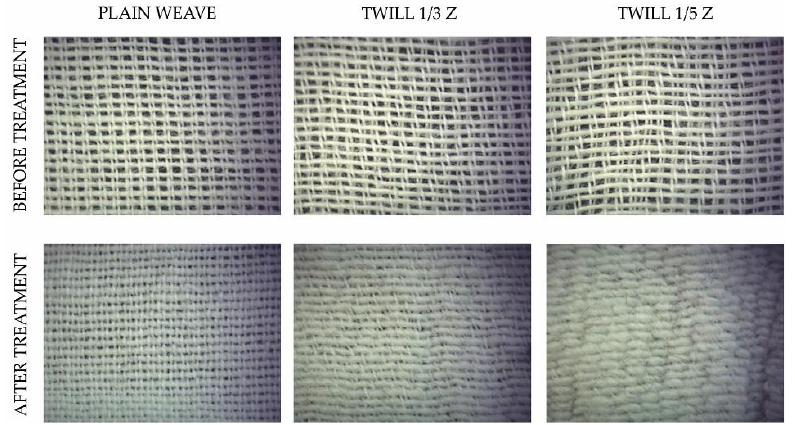
Figure 4. Pictures of samples produced with untreated Co/PBT yarn in weft, before and after ther- mal treatment of